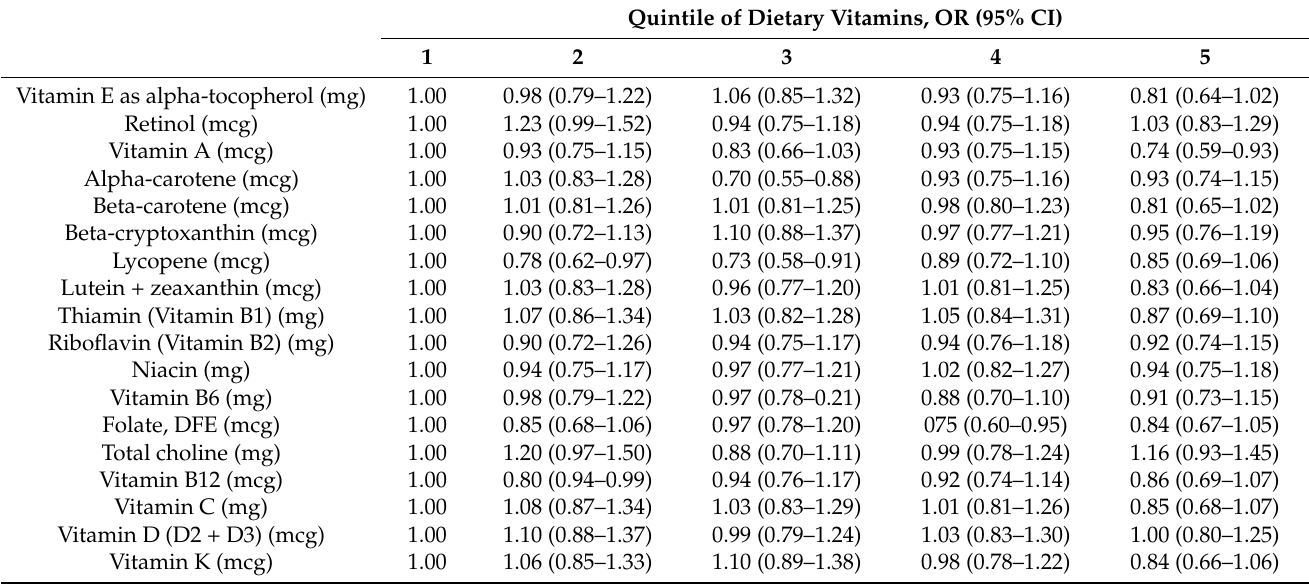
Table 5. Univariate logistic regression analysis of association of dietary vitamins with self-reported eye affliction/retinopathy in individuals with